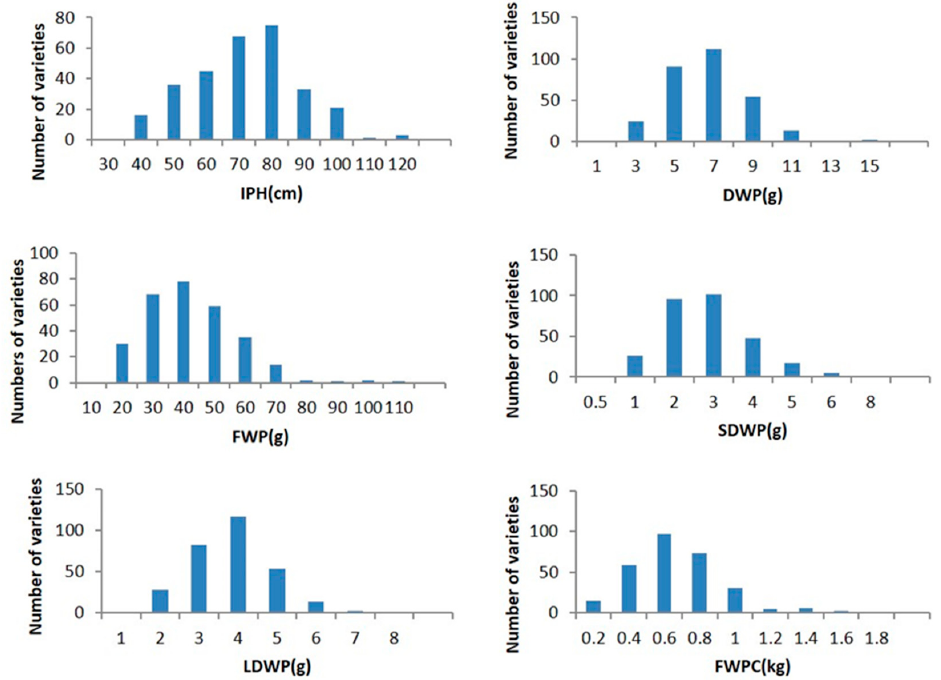
Figure 2. Frequency distribution of the 6 traits among the 301 ramie accessions (2020). Notes: IPH (individual plant height), FWP (fresh weight per plant), DWP (dry weight per plant), LDWP (leaf dry weight per plant), SDWP (stem dry weight per plant), and FWPC (fresh weight per clump).